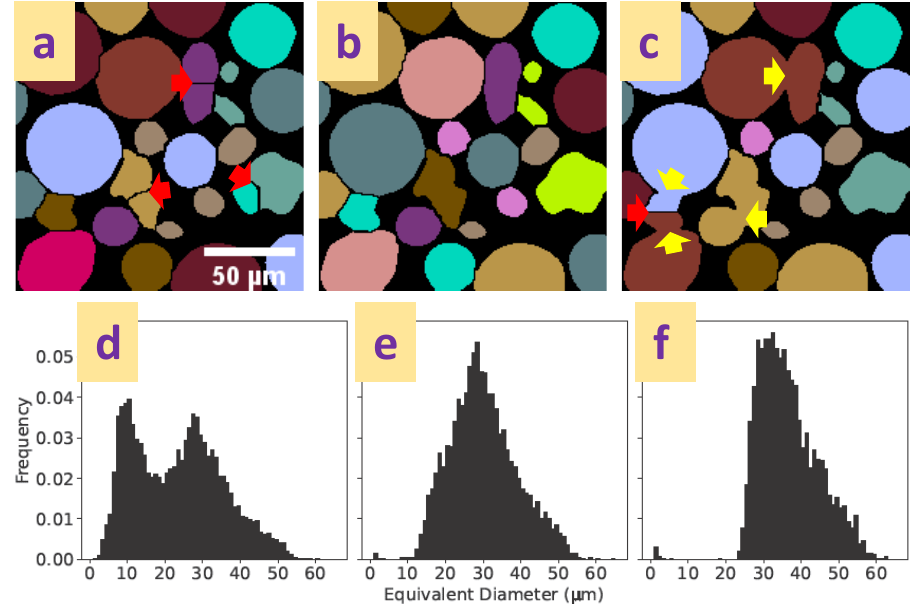
Figure 7. Segmentation errors and their effect on the particle size distribution of a copper powder with a manufacturer’s size range of 15–45 µ m. Top row: ( a ) over-segmentation with increased splitting of particles (red arrows), ( b ) visually correct segmentation, ( c ) under-segmentation with increased merging of particles (yellow arrows). Segmentation differences are a result of varying the extrema marker extend (Figure 6e) during the watershed process. Segmentation with the open-source ImageJ plugin MorphoLibJ [82]. Bottom row: Particle size distributions for the full datasets: ( d ) 8800 particles ( e ) 5700 particles, ( f ) 3300 particles resulting from the segmentations shown in top row ( a – c